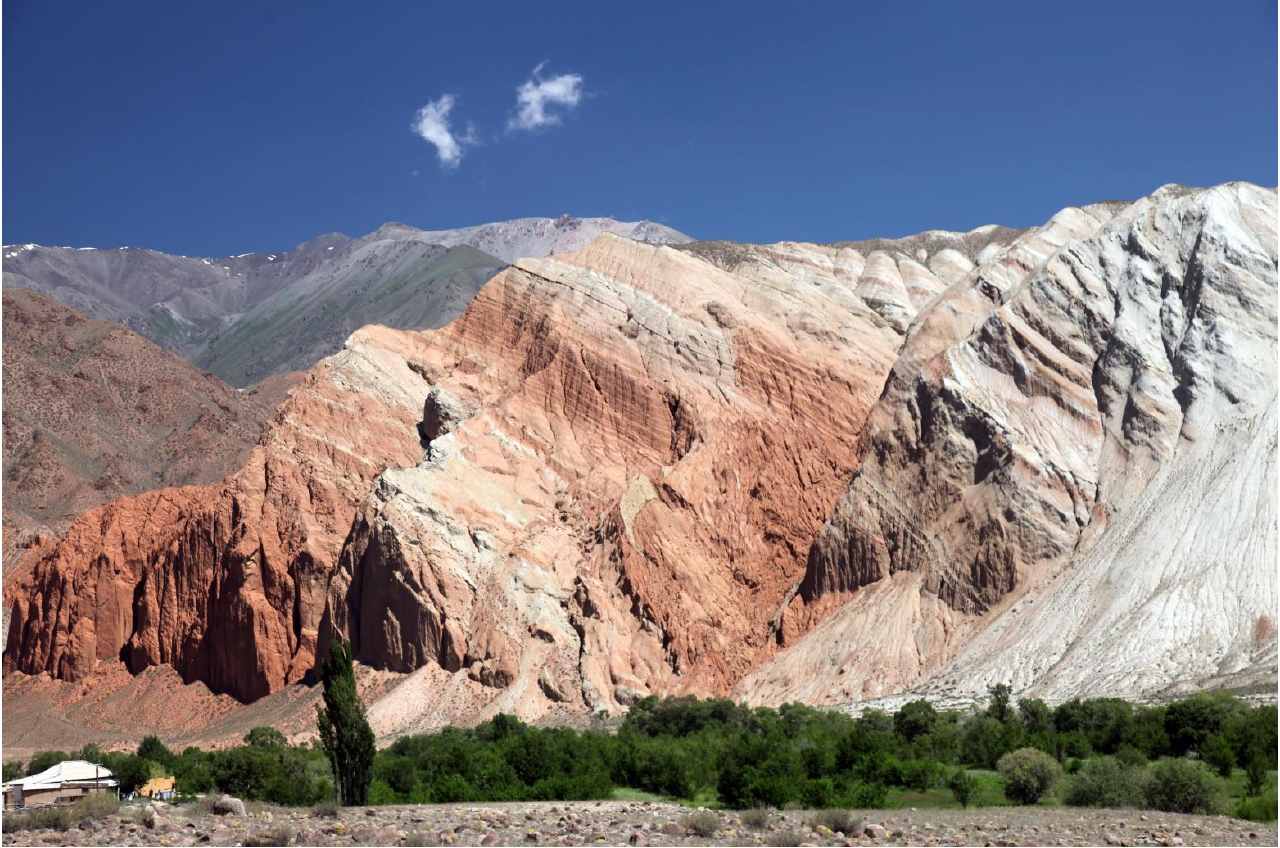
Fig. 7. Eastern spurs of Dzhumgaltoo Mts., Seuok river valley, Seuok village. Typical biotope of various Lycaenids ( Polyommatus icarus, P. icadius, Rueckbeilia fergana